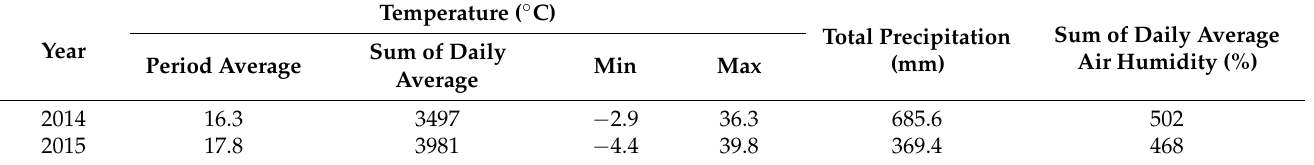
Table 1. Reference information for climatic parameters (1 March–30 September).